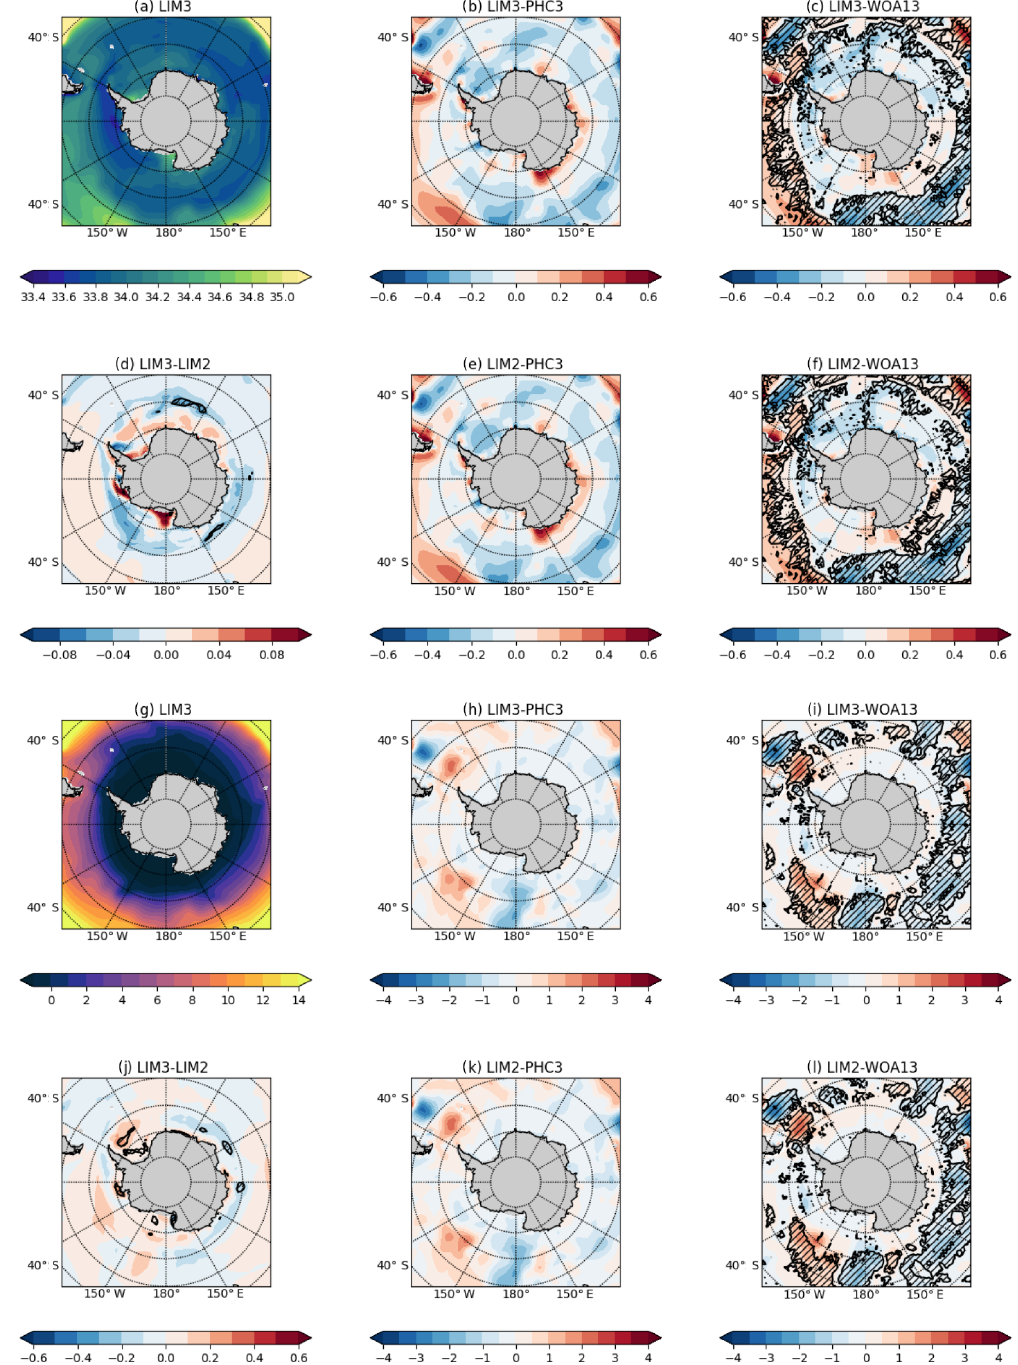
Figure 6. As Fig. 5, but for the Southern